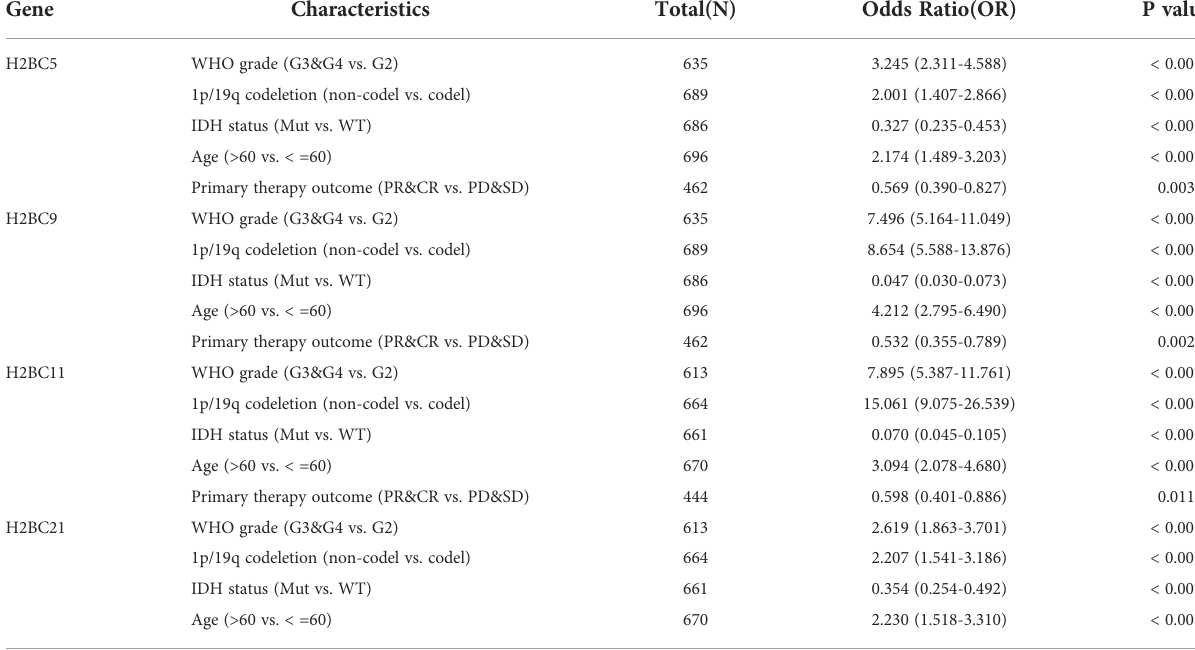
TABLE 3 Logistic regression of H2B